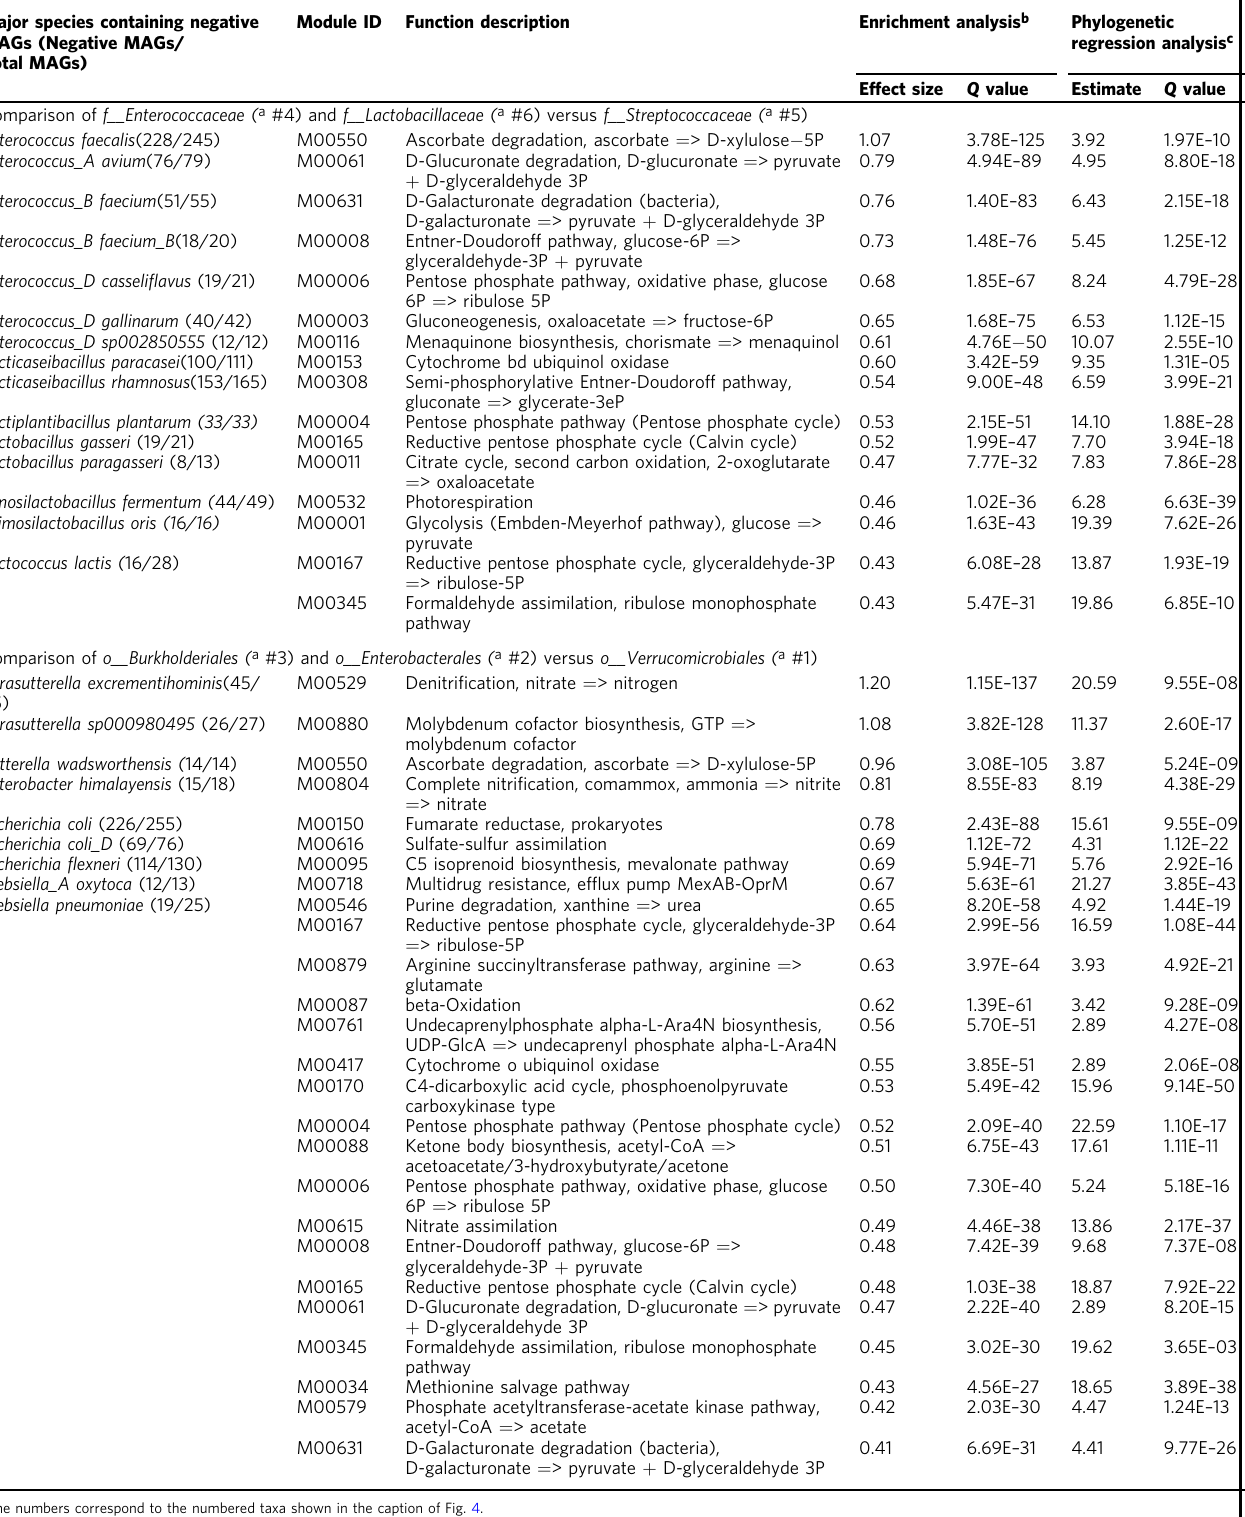
Table 2 Comparative genomics of the taxa containing MAGs negatively associated with IA